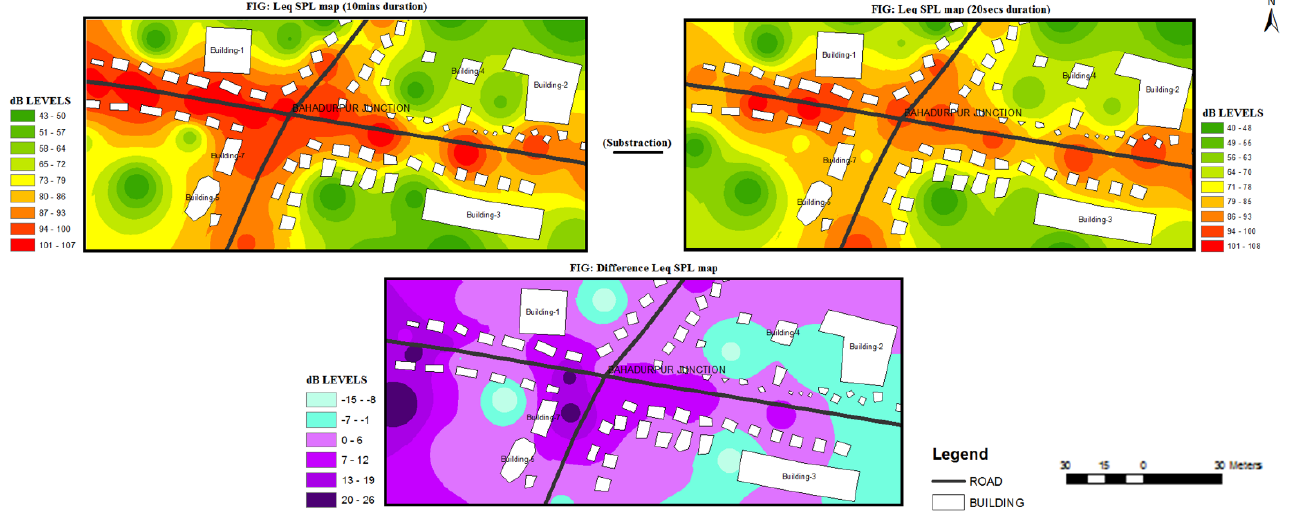
Figure 18. Long vs. short noise sampling duration based noise prediction and their difference at the M4 time interval (3–5 PM) for the Bahadurpur study area.